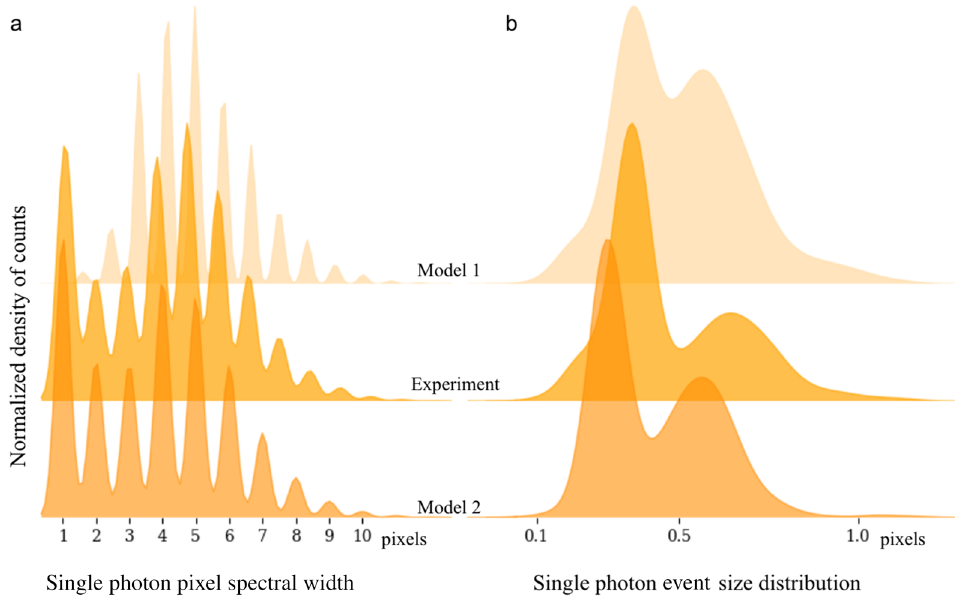
Figure 4. Single charge cloud pixel and size distribution of experimental and simulated data. The analysis described Fig. 3 is repeated over 50 speckle patterns with an applied threshold of 0.05 photon, comparable to experimental readout noise level. ( a ) Two models of charge clouds size distribution (fixed and variable charge cloud size) are compared to experimental data. ( b ) Single photon event size distribution from the Gaussian model in Eq. 2. The simulation based on a weighted photon size distribution reproduces the experimental findings.